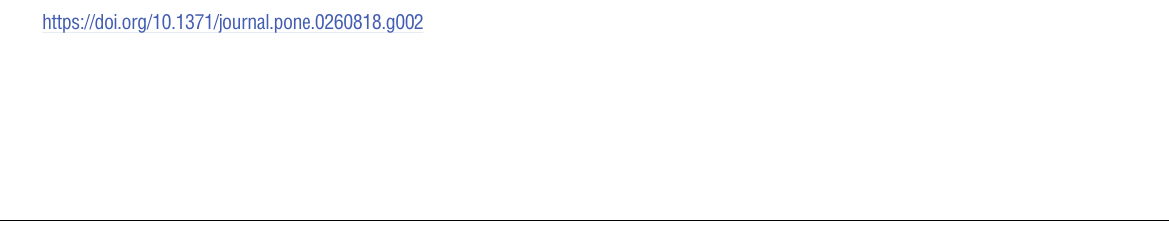
PLOS ONE | https://doi.org/10.1371/journal.pone.0260818 December9,